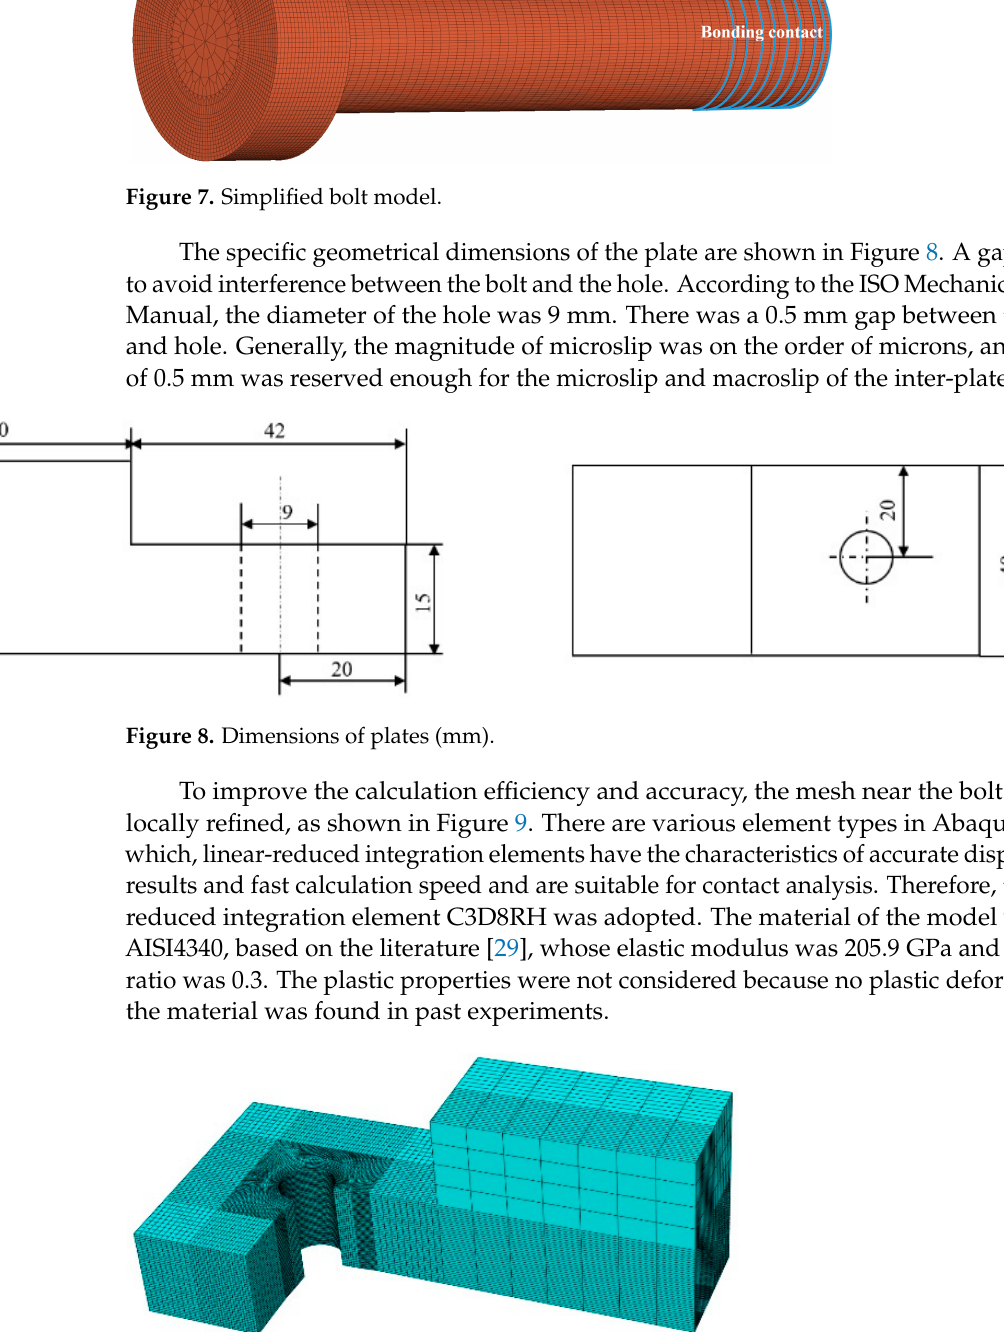
Figure 9. Cross section of the finite element model of the plate.